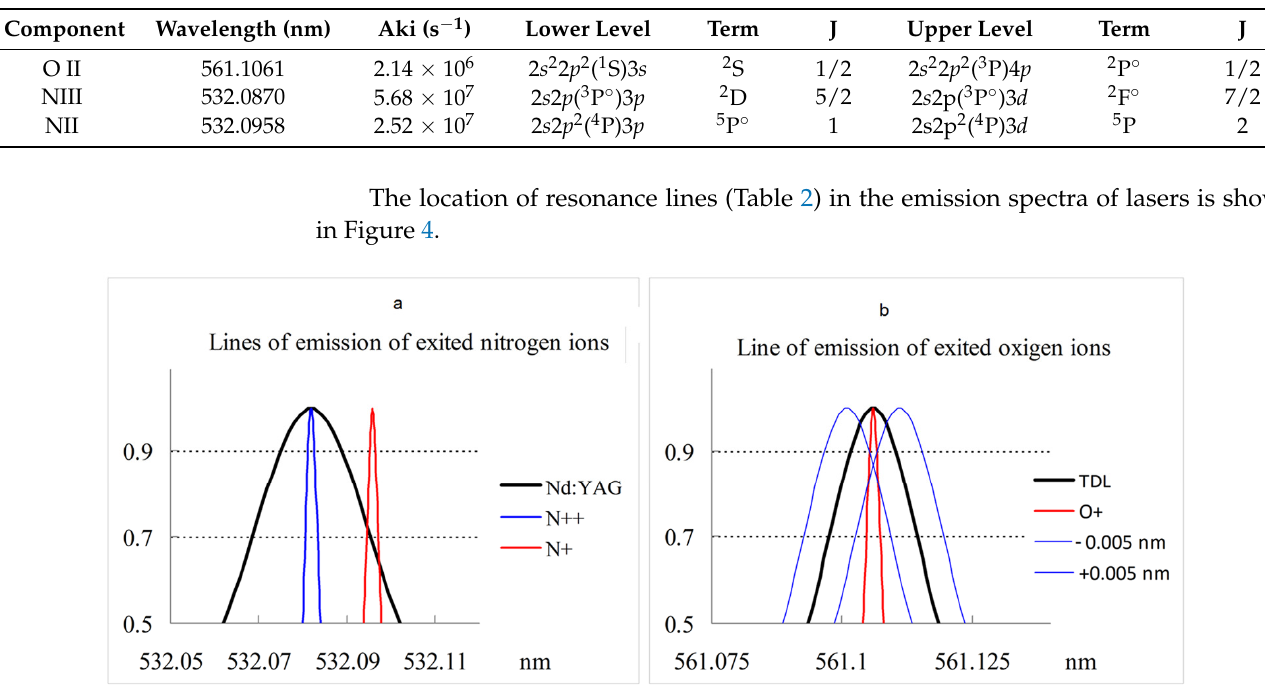
Figure 4. Emission lines of excited nitrogen ( a ) and oxygen ( b ) ions in the emission spectra of the Nd:YAG and TDL lasers.